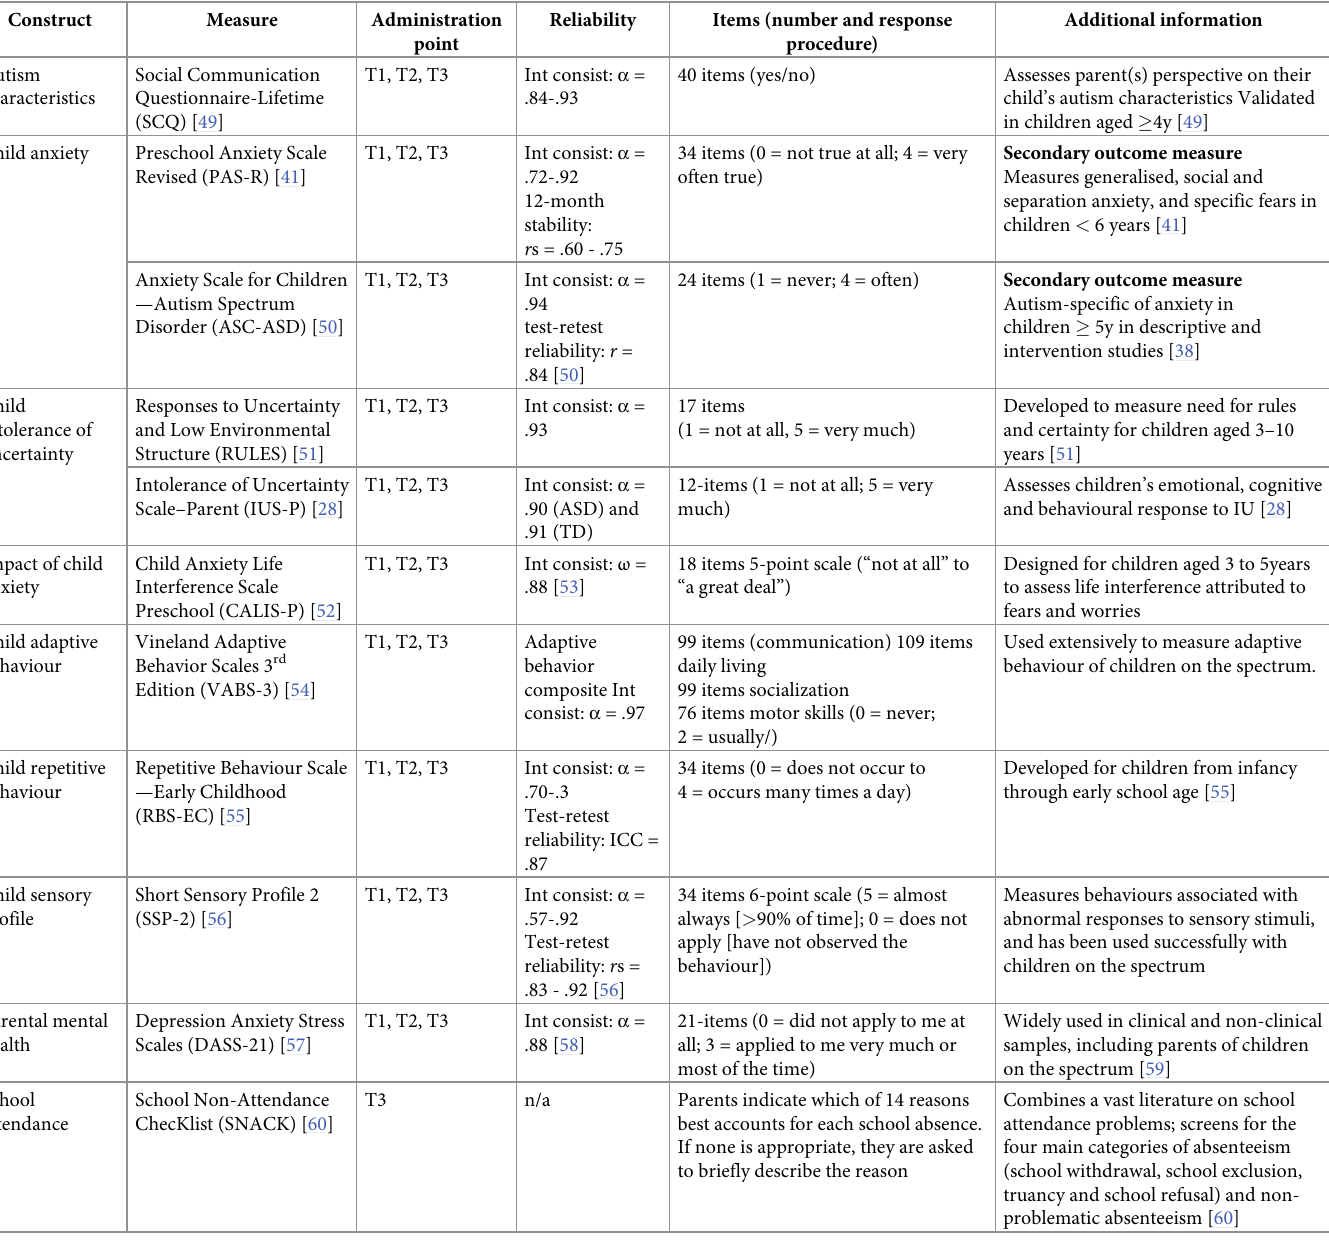
Table 2. Parent measures used in